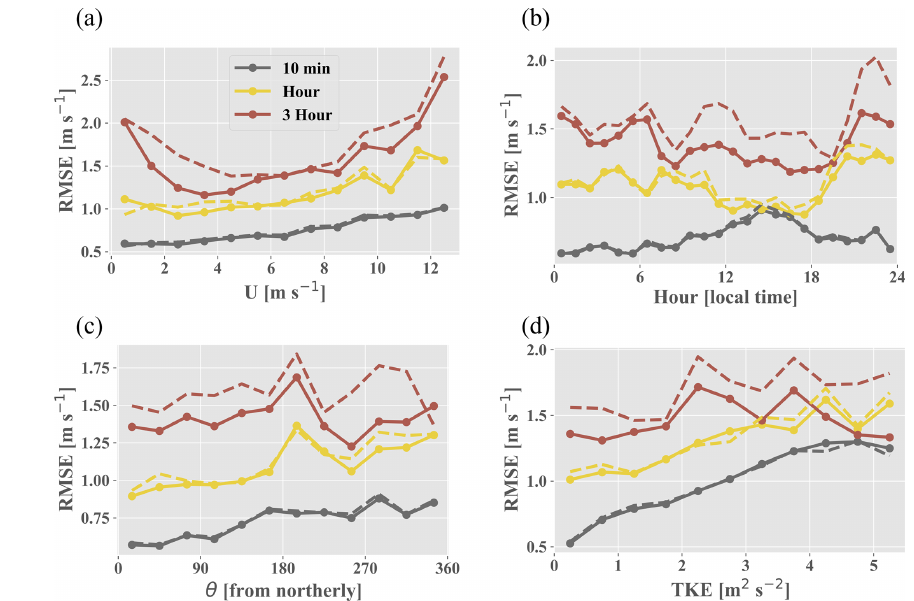
Figure 6. RMSE obtained by the ARIMA–RF (with the full feature set; solid lines with points) and BCA (dashed lines) partitioned by (a) U , (b) hour of the day (local time), (c) θ , and (d) TKE.